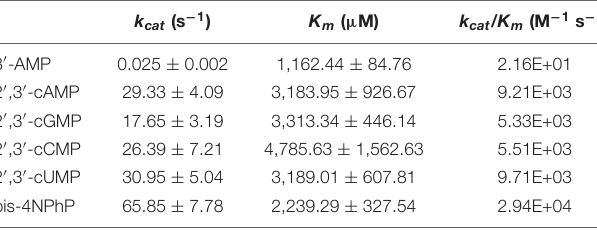
TABLE 4 | Kinetic parameters of double mutant Y530A+Y633A-SntA.